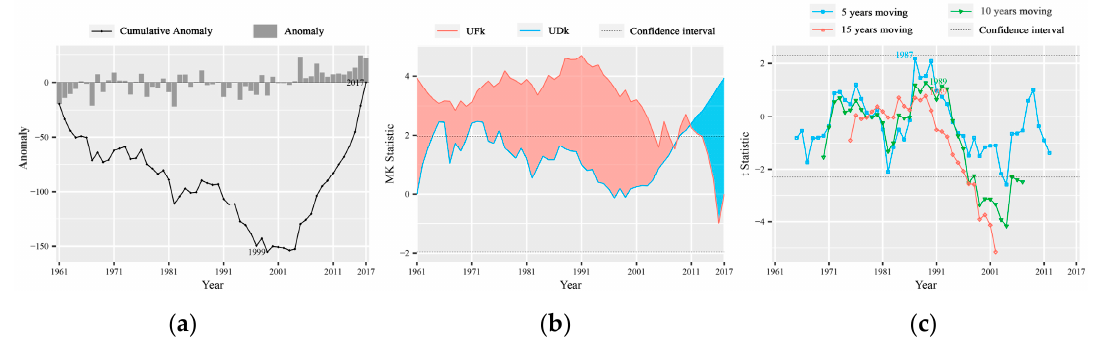
Figure 6 Figure 6. The abrupt change point identification diagram of winter ET 0 sequence, where the picture category of the ( a – c ) is same to Figure 2.